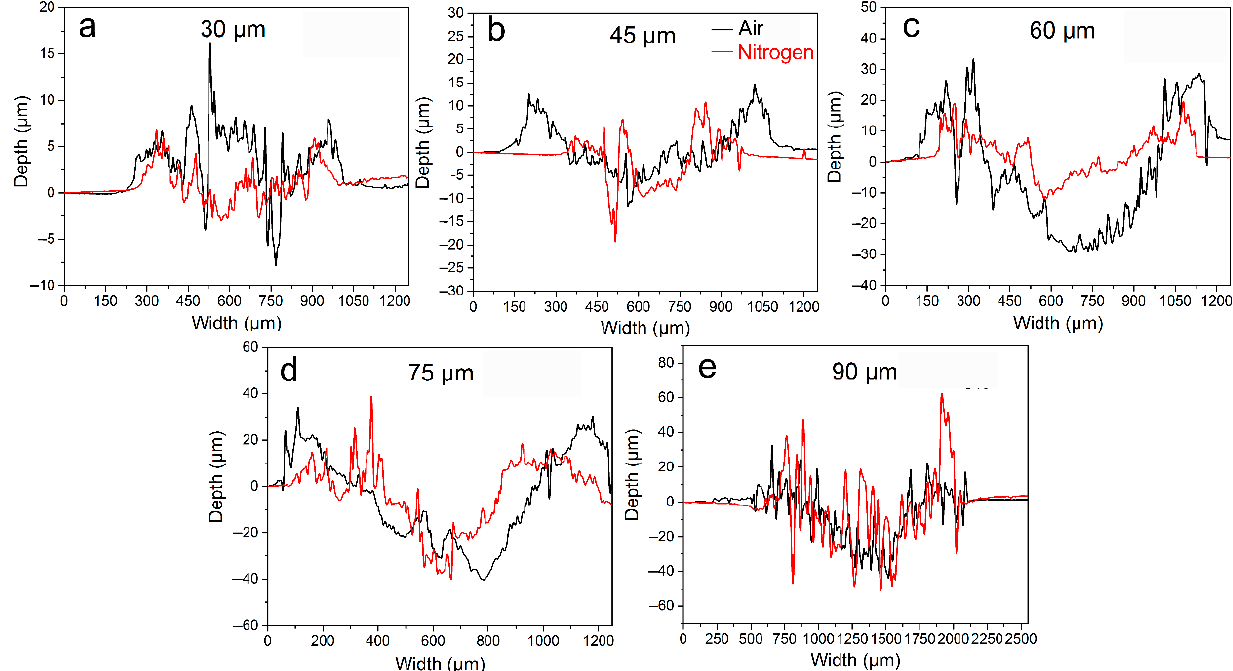
Figure 4. The typical cross-sectional profile of worn scars of alloy 690TT at the displacement amplitude of ( a ) 30 μ m, ( b )